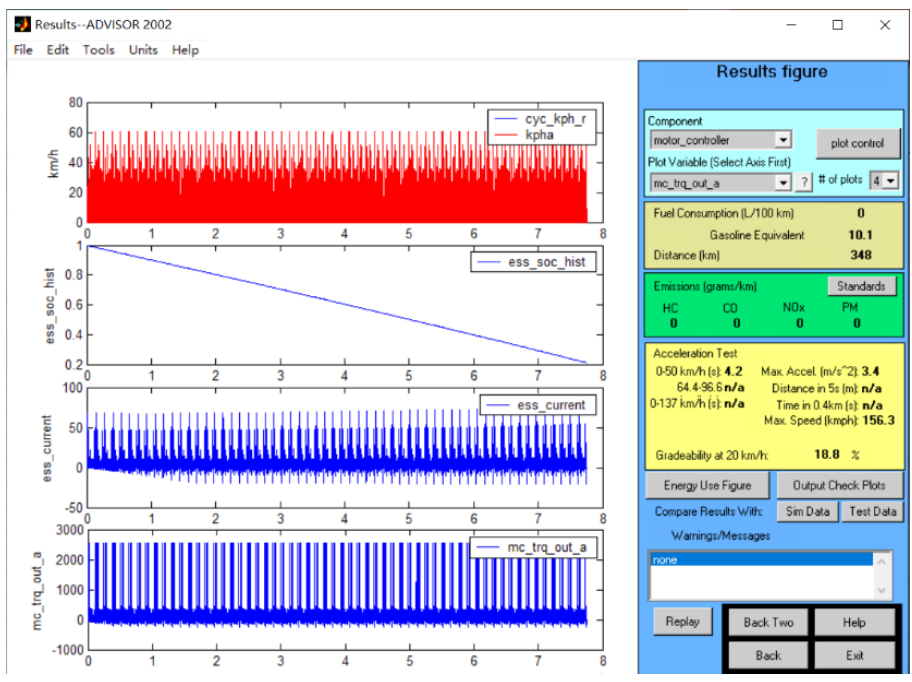
Figure 16. Simulation results of experiment 8.